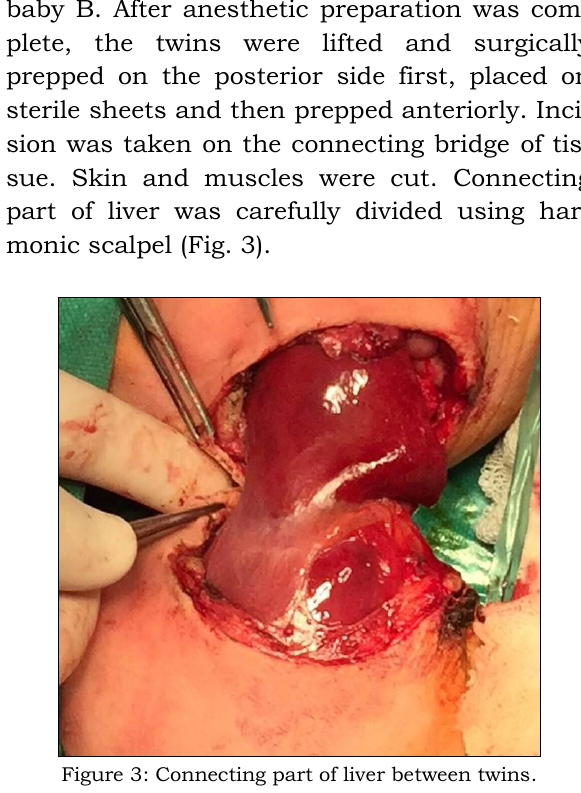
shifted to pediatric surgery intensive care